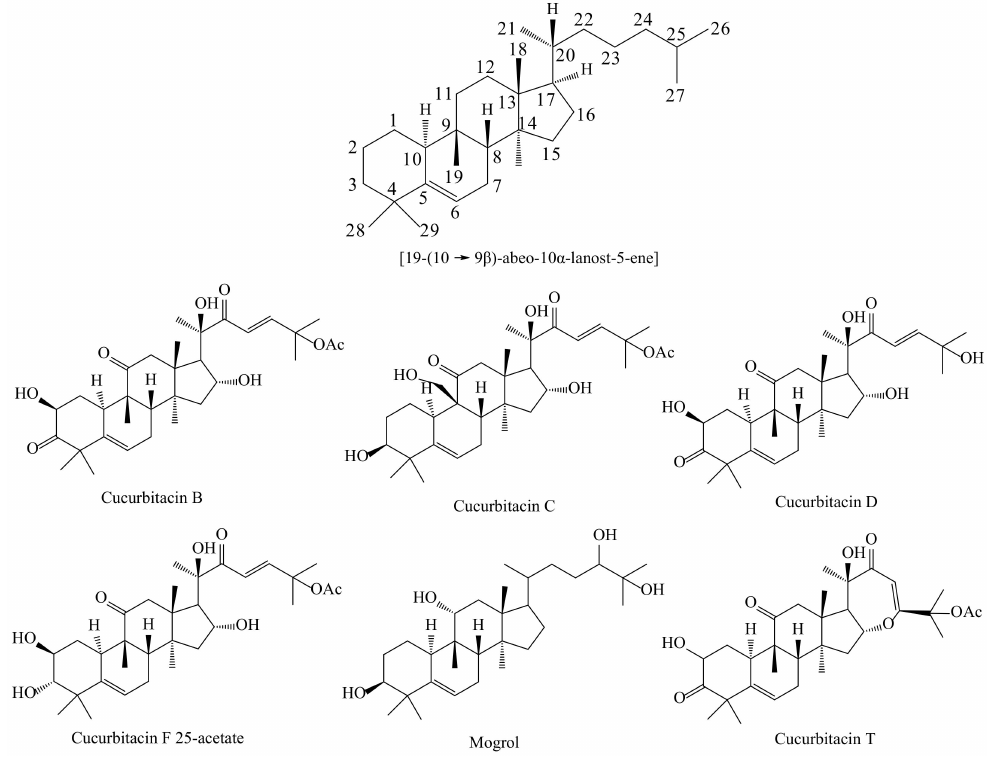
Figure 1. Structure of